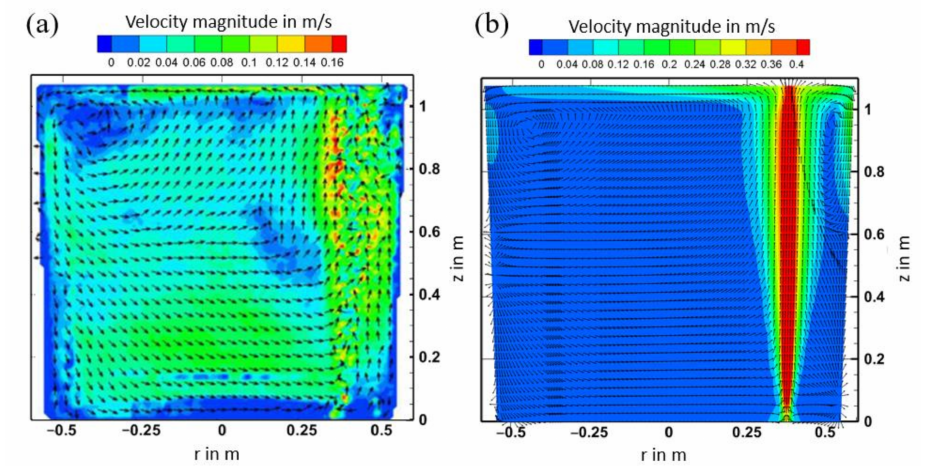
Figure 6. Velocity fields of particle image velocimetry (PIV) and simulated results: ( a ) PIV result [51]; ( b ) simulated